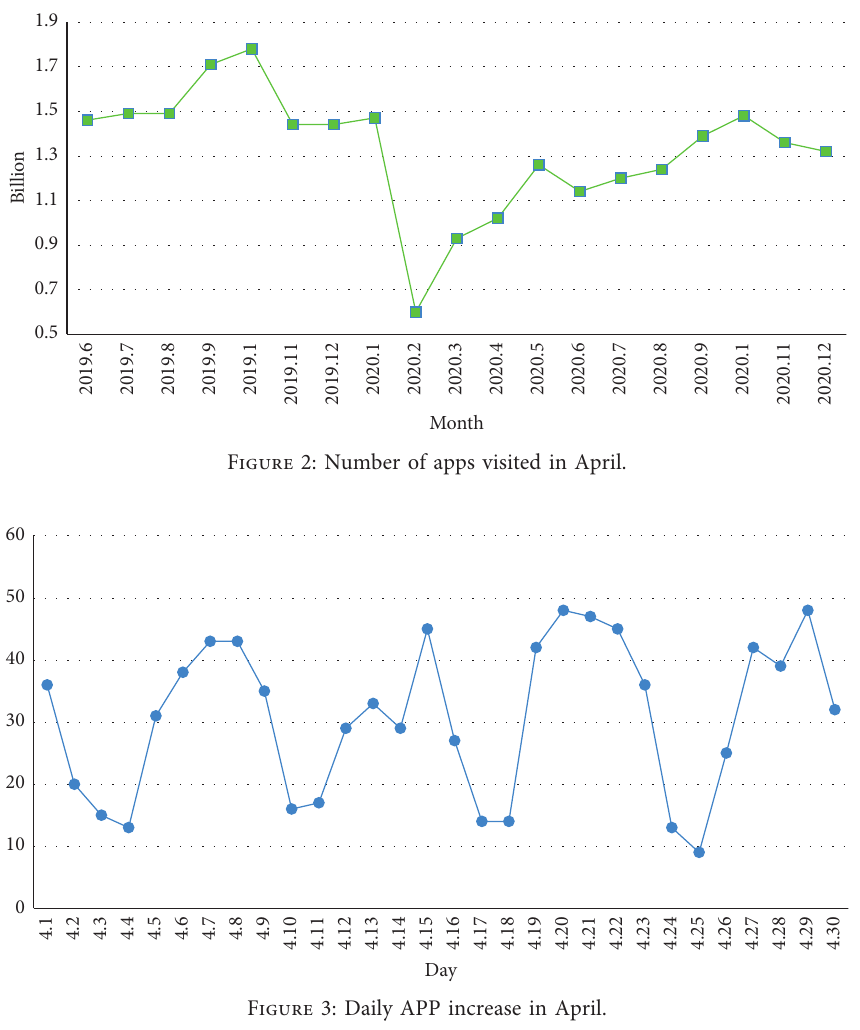
Figure 3: Daily APP increase in April.